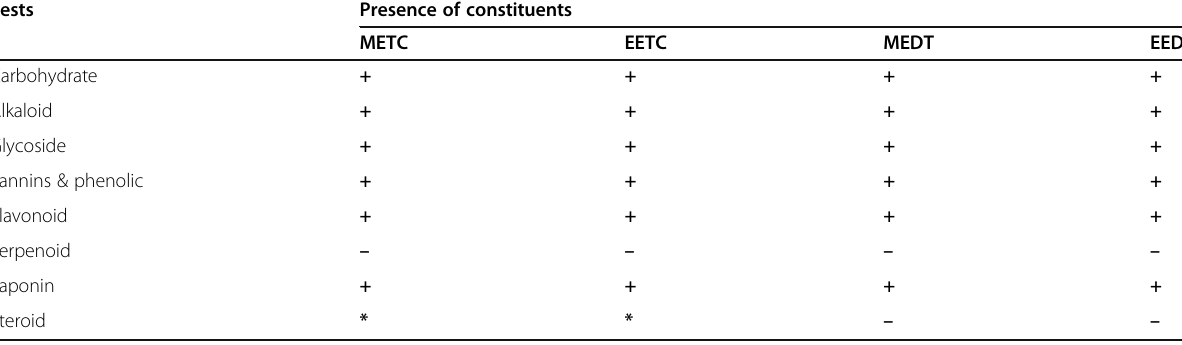
Table 2 Presence of phytoconstituents in different test extracts Tests